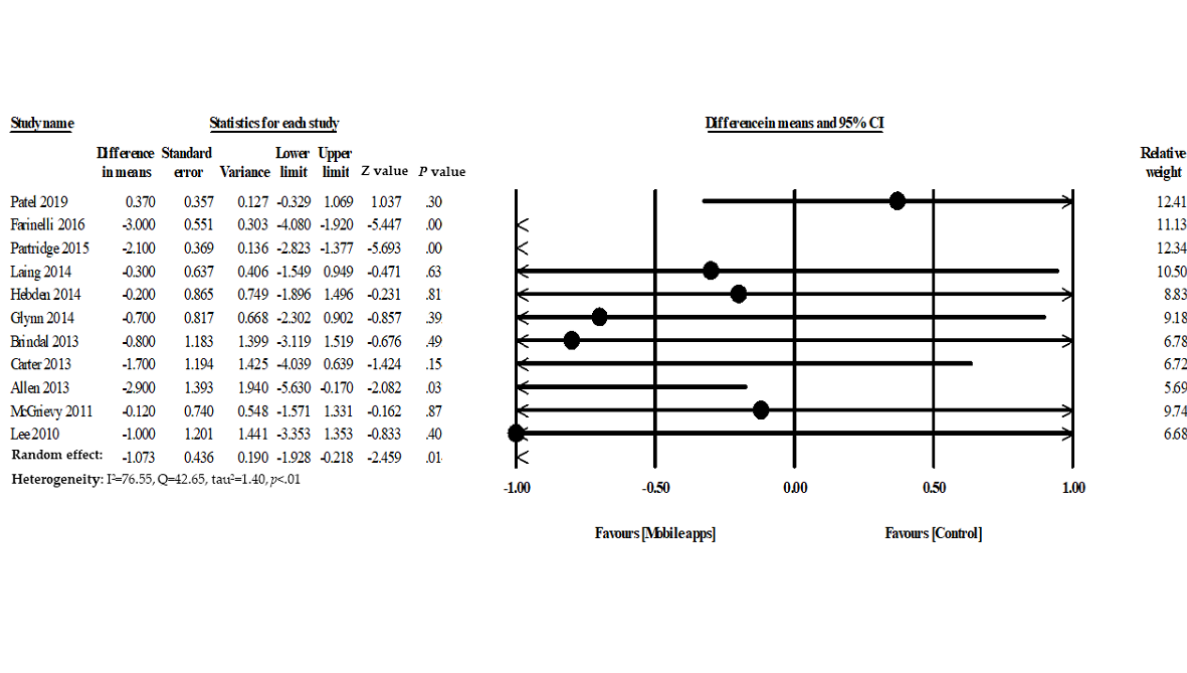
Figure 3. Forest plot of mobile phone app interventions and weight loss.